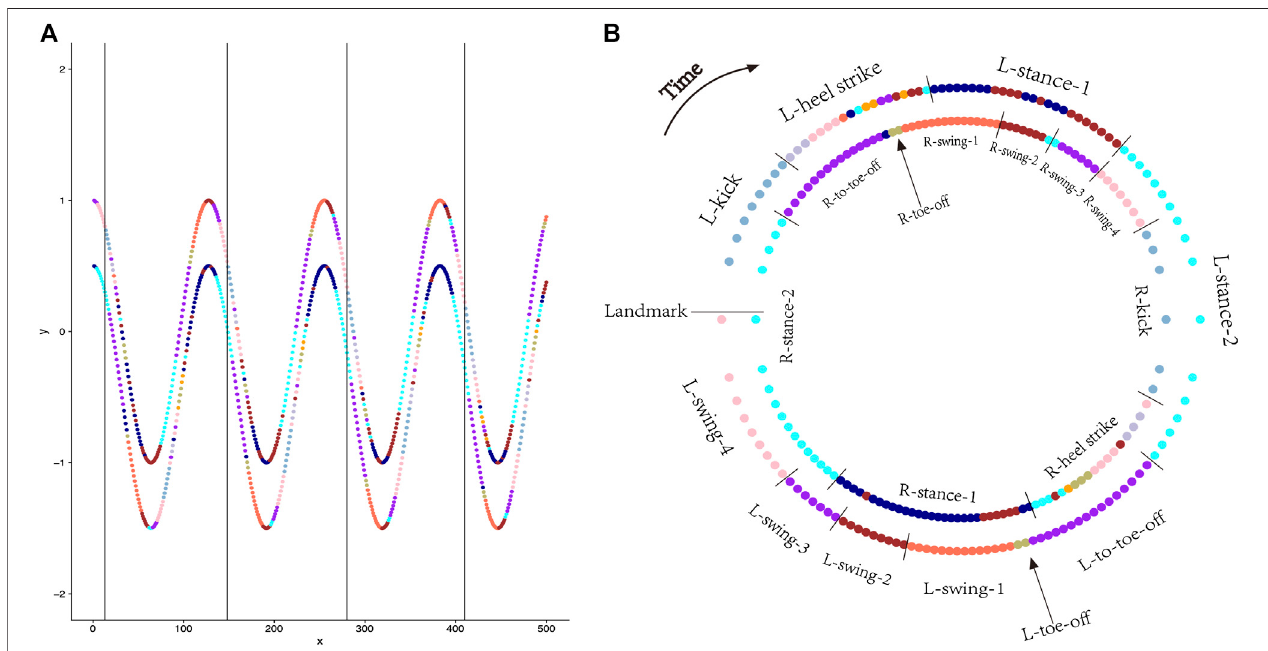
FIGURE 5 | Color-coded rhythmical cycles in L + R system of subject #5 marked with serial biomechanical phases. (A) The coupled color-coding time series on temporalperiod [1,500](uppercurve fortheleft-foot, and lowercurvefortheright-foot).Thelandmarksaremarkedwithverticalblacklines. (B) Rhythmiccycle,thethird one in panel (A) , is represented by two concentric rings (outer ring for the left-foot, and inner right for the right-foot). The temporal coordinates go